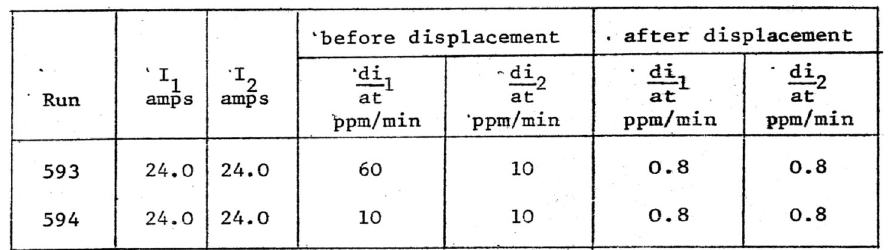
FIG. 11. Beam decay rates before and after beam